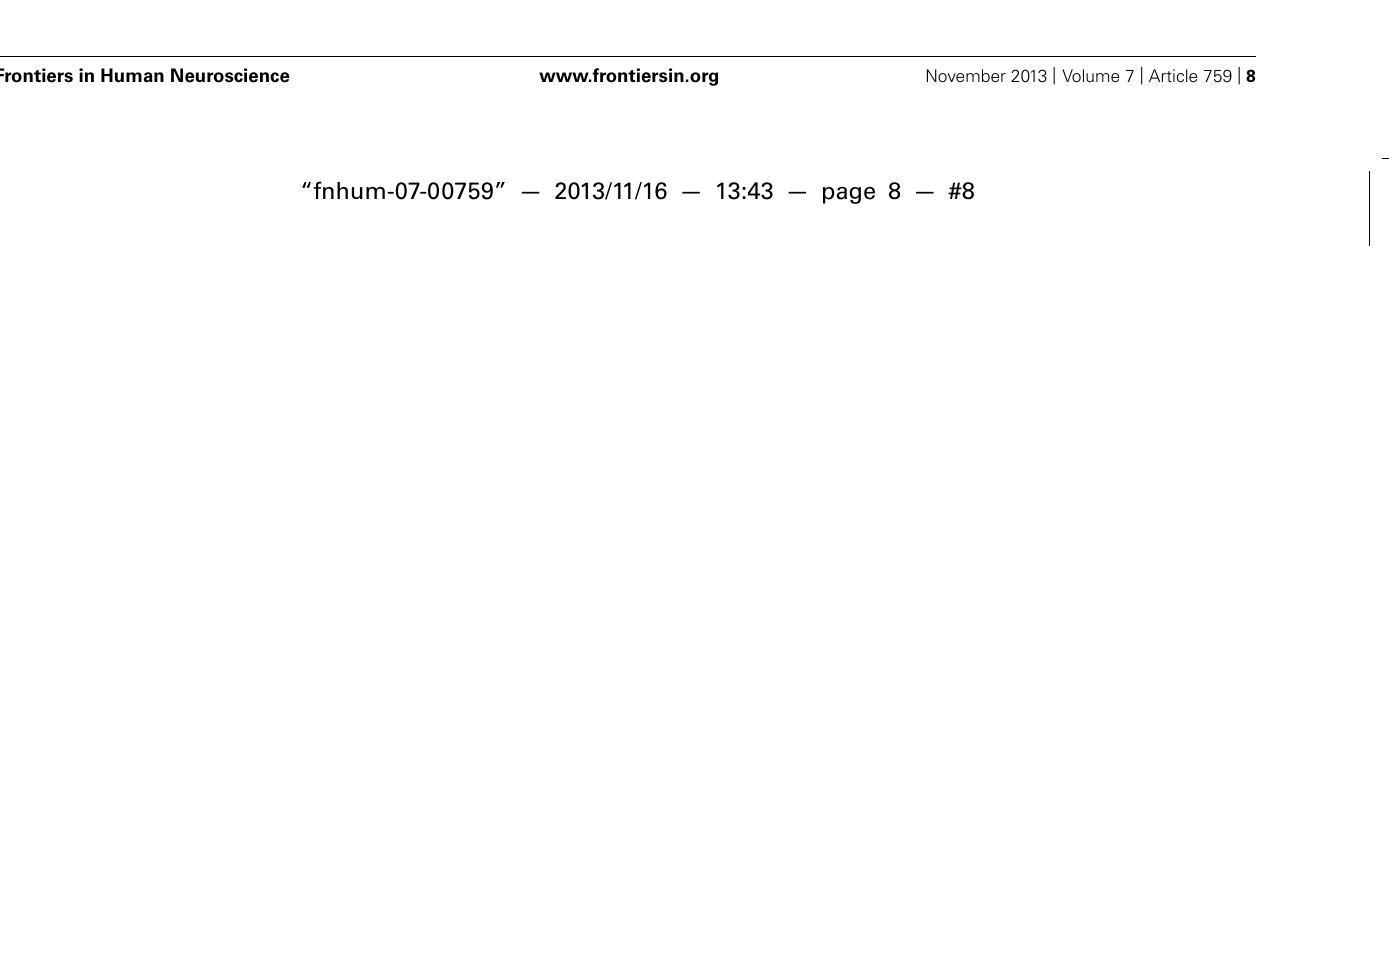
FIGURE 3 | Laterality analysis : (A) contrasting affixed ([-s], [-er]) and non-affixed ([-on]) deviants, showing increased left-lateralization for affixed deviants (asterisk signifies laterality significantly greater than zero at p < 0.05); and (B) contrasting verb ( bakes ) and noun ( beaks ) deviants, showing increased left-lateralization for the verb compared to the noun from 160 to 240 ms (asterisk signifies p < 0.05), and at